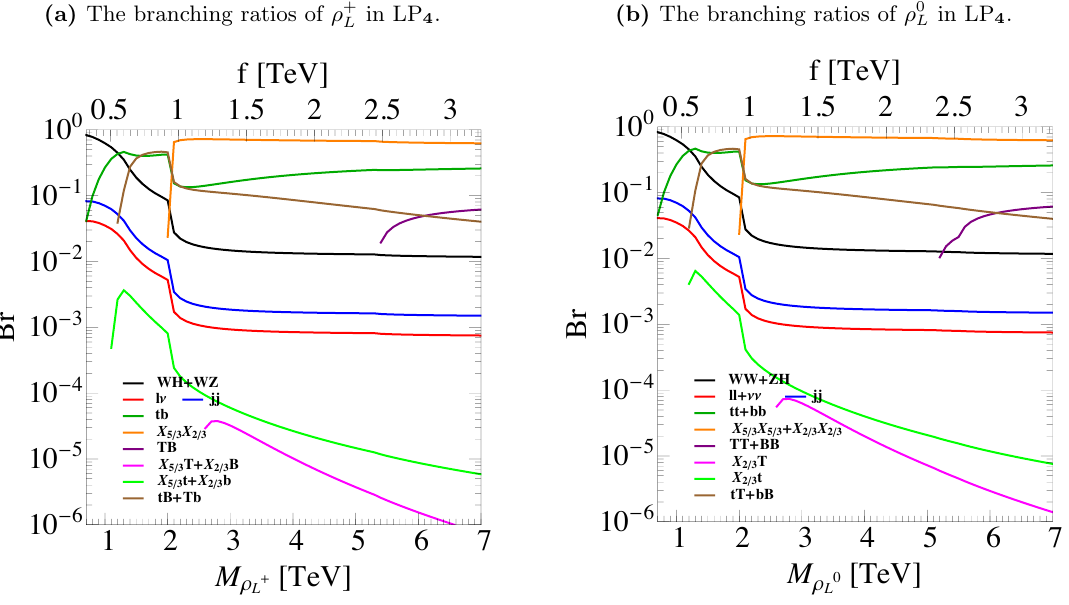
(a) The branching ratios of (cid:26) +